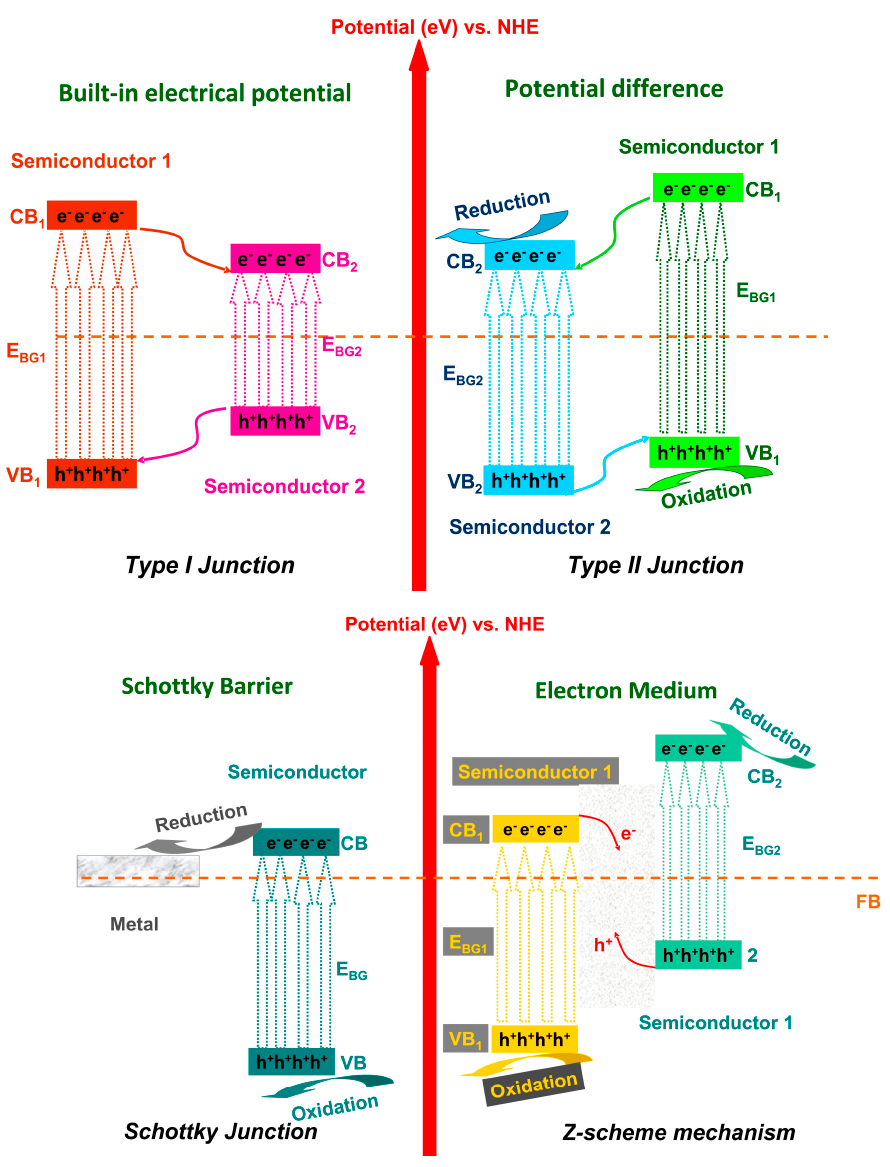
Figure 1. EnergydiagramsoftypeIjunction, typeIIjunction, Schottkyjunction,